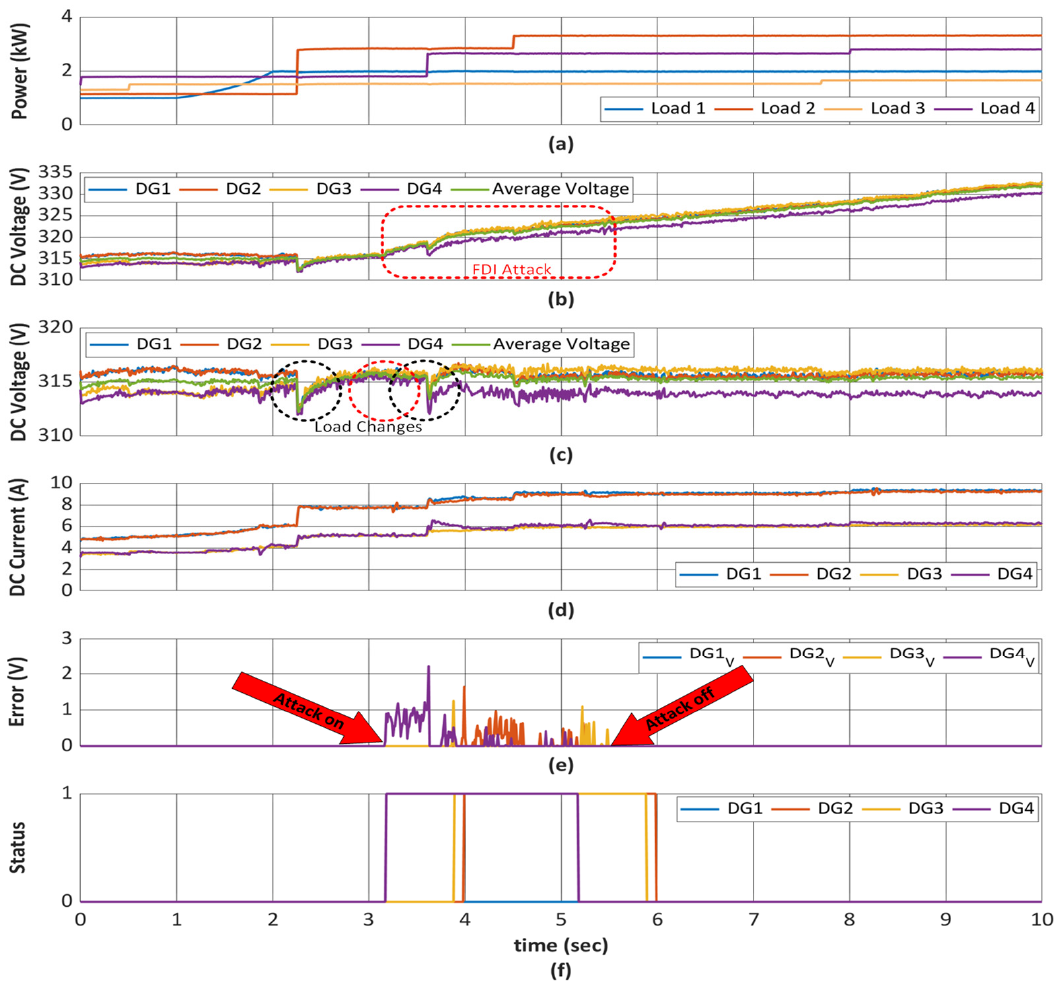
Figure 7. System performance in the presence of Gaussian-distributed attack in voltage sensor: ( a ) Load profiles. ( b ) Output DC voltages of a standard secondary controller. ( c ) Output DC voltages with proposed method. ( d ) Output current with proposed method. ( e ) Error signals. ( f ) Final status of DGs in terms of attack presence.